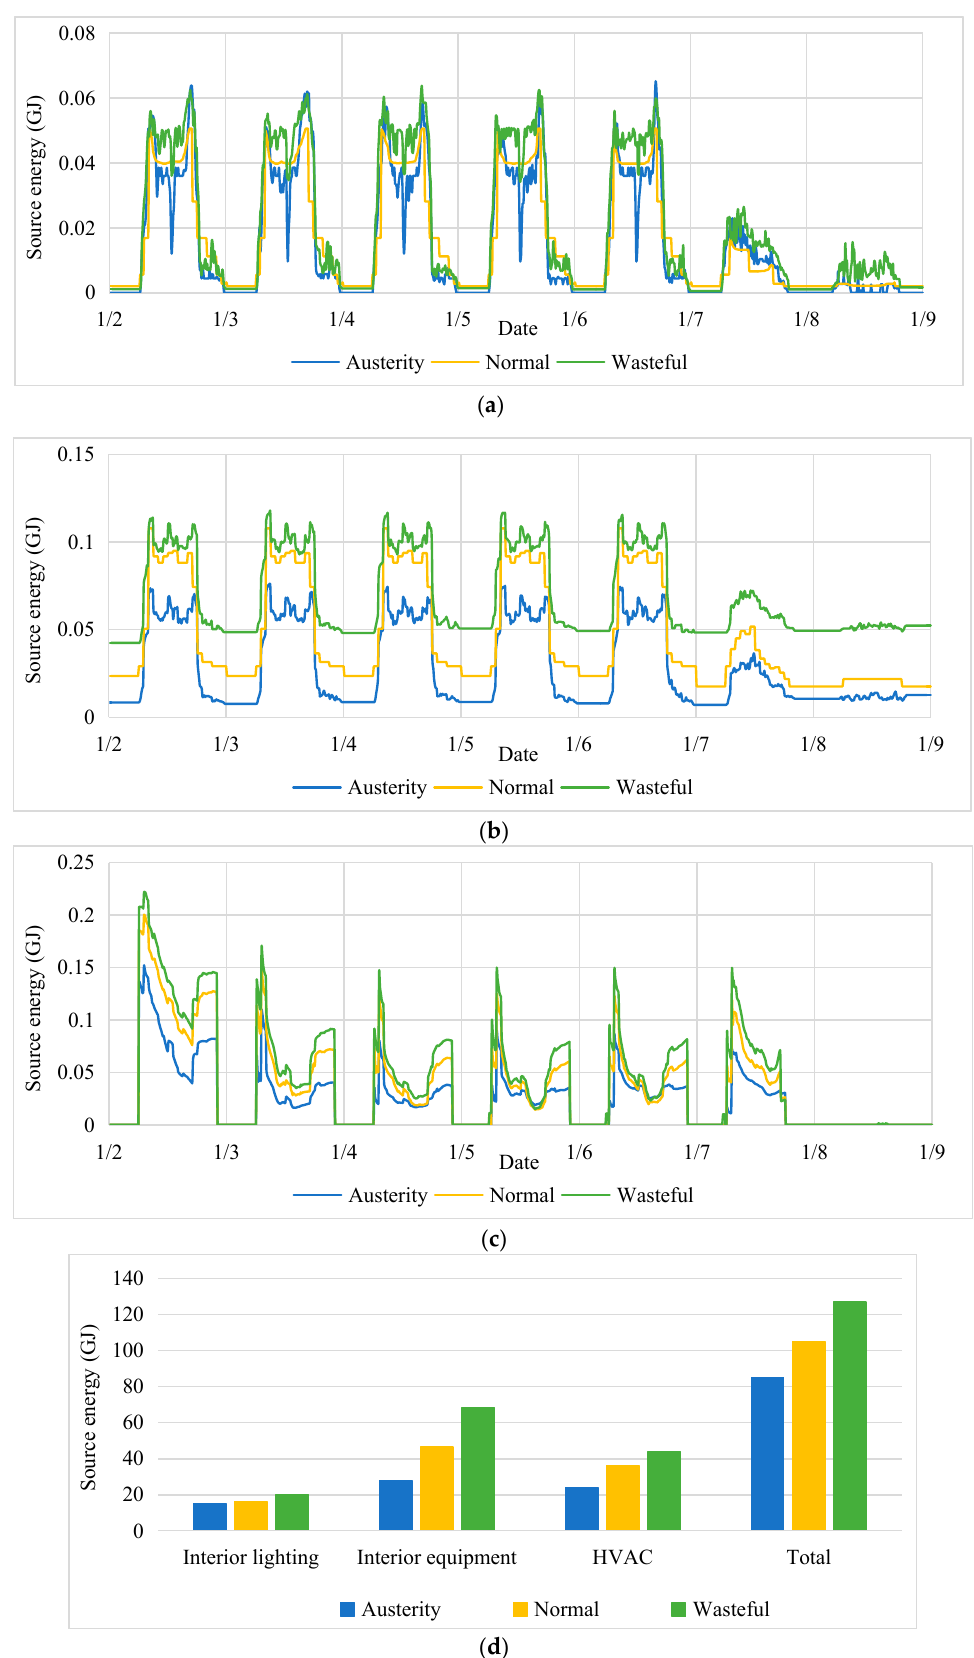
Figure 9. The weekly source energy for the three models in Seattle in 2019: ( a ) Interior lighting; ( b ) Interior equipment; ( c ) HVAC; ( d ) Weekly source energy.